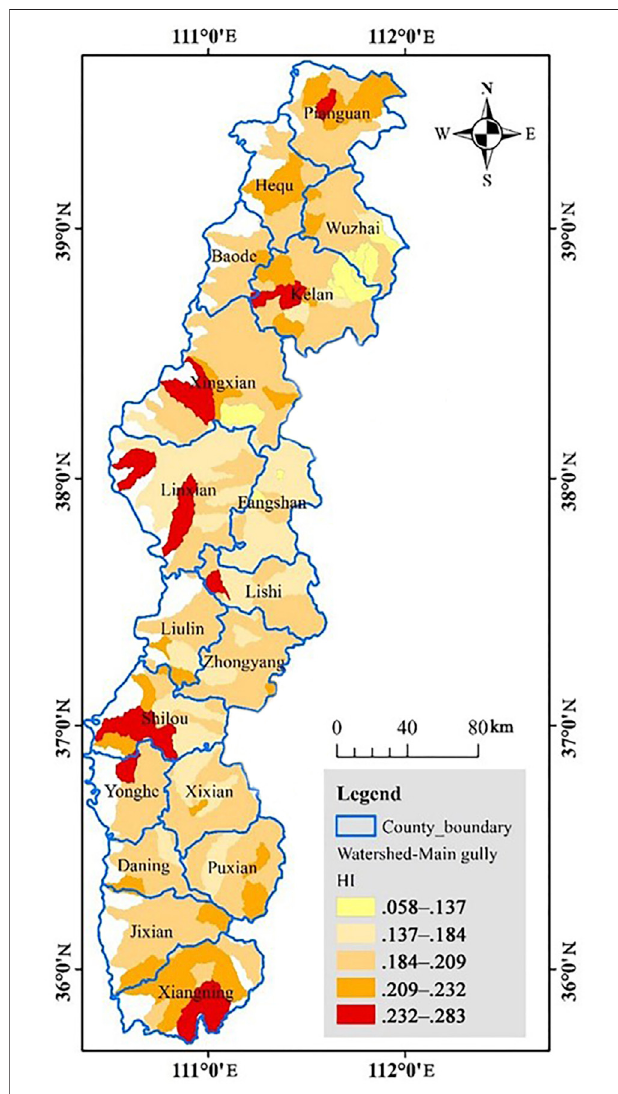
FIGURE10| Mapofthespatialdifferentiationofthehypsometricintegral (HI) of the watershed-main gully.